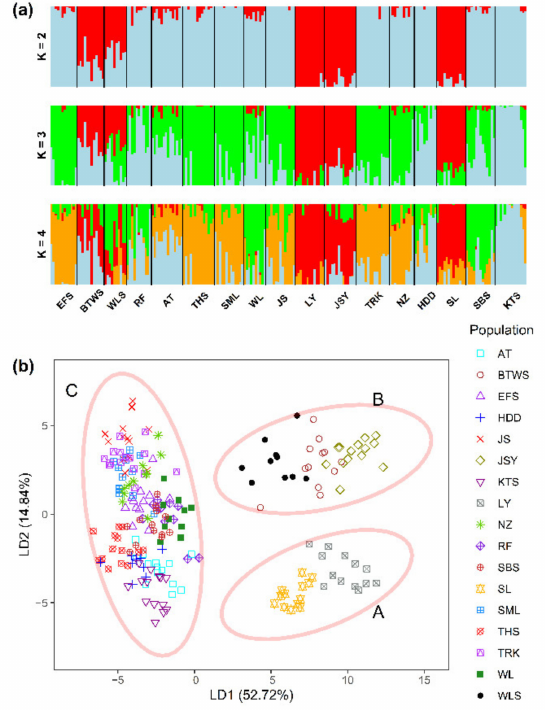
Figure 2. Analysis of genetic homogeneous groups of 212 individuals of Zingiber kawagoii based on the total AFLP variation using LEA ( a ) and DAPC ( b ). The clustering scenarios for K = 2–4 were displayed in LEA. The two linear discriminants LD1 and LD2 of DAPC described 52.72% and 14.84% of the total AFLP variation,